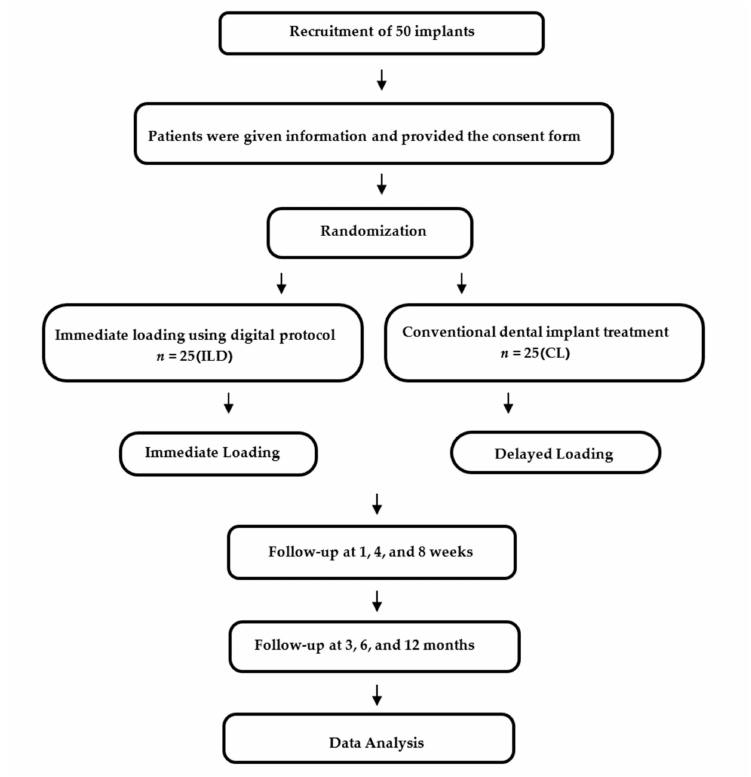
Figure 1. Flowchart for the